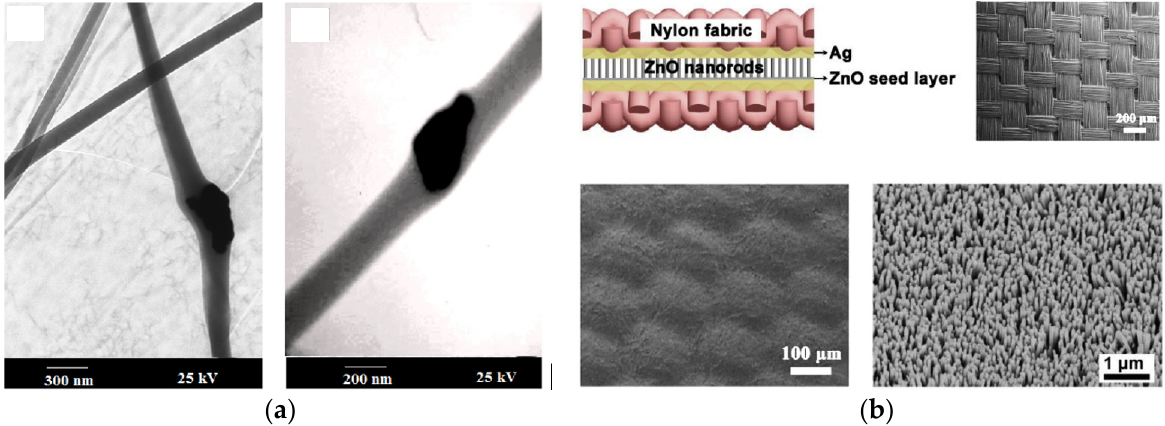
Figure 5. Examples of recent developments toward piezoelectric energy harvesting materials and structures for textile application: ( a ) PZT-PVDF nanocomposite nanofibers (reproduced from [80] with permission from Elsevier); ( b ) array of vertical ZnO nanorods on a silver coated polyamide fabric (top left cartoon: PENG structure, top right picture: uncoated woven fabric, bottom left picture: silver-coated fabric, bottom right picture: ZnO nanorods-coated fabric, reproduced from [83] with permission from Elsevier).